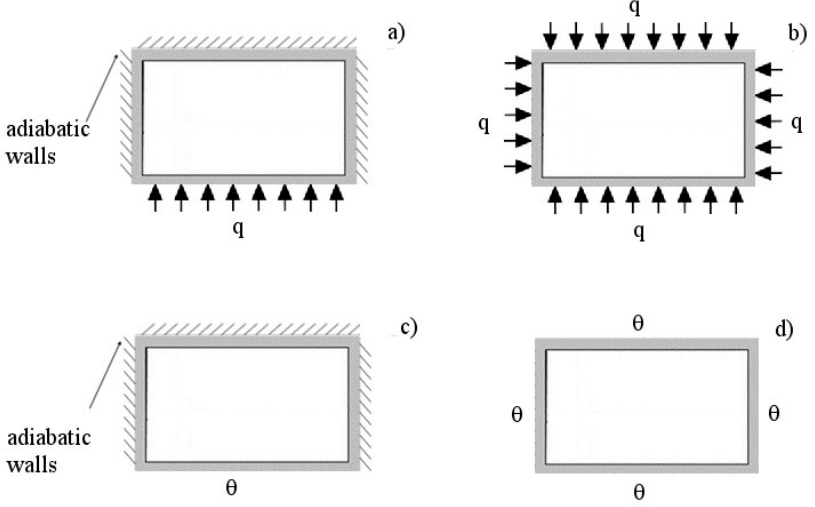
Figure 1. Sketch of the thermal boundary conditions considered in the present study; ( a ) H2,1L; ( b ) H2,4; ( c ) H1,1L; ( d ) H1,4.